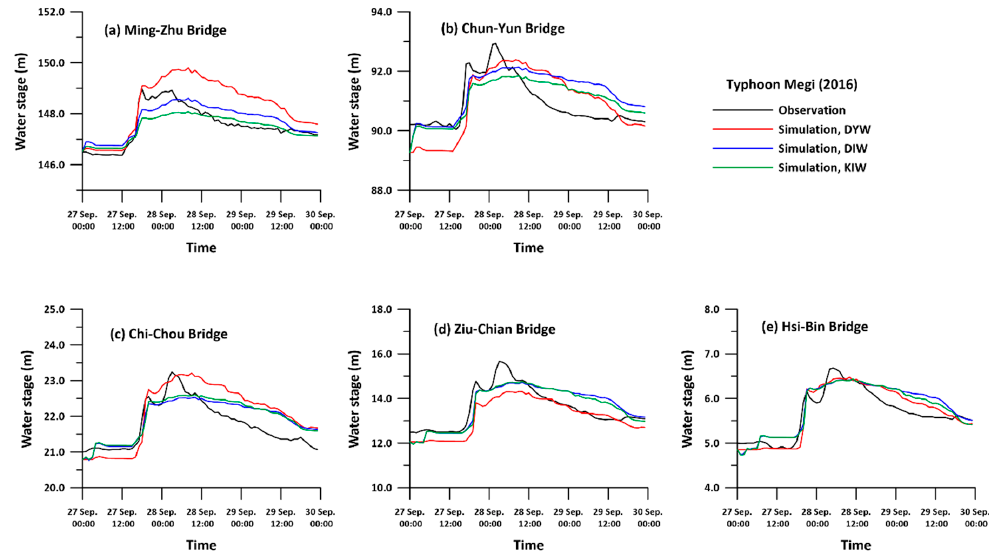
Figure 11. DYW/DIW/KIW simulations of Typhoon Megi (2016).